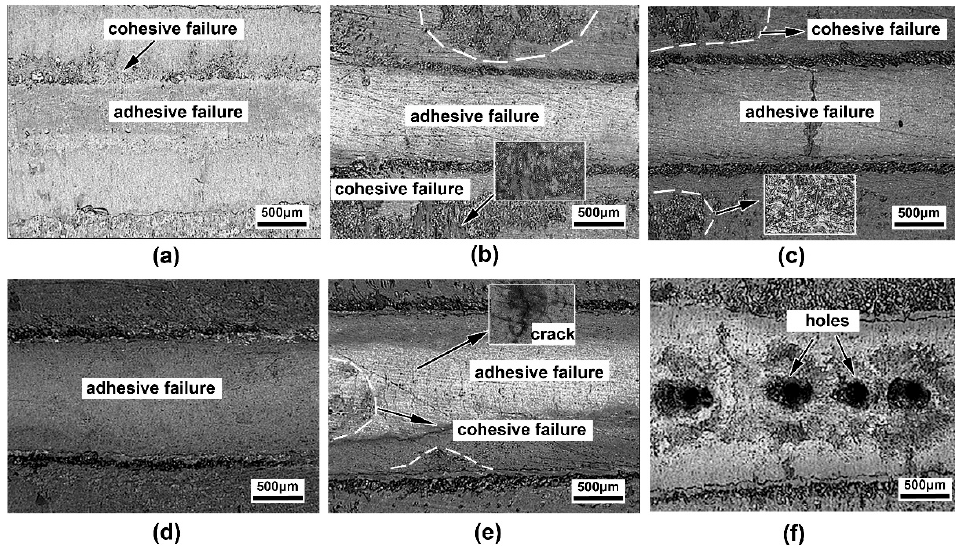
Figure 7. Details of fracture surface at different welding speed: ( a ) 16 mm/s, ( b ) 14 mm/s, ( c ) 12 mm/s, ( d ) 10 mm/s, ( e ) 8 mm/s, and ( f ) 6 mm/s.